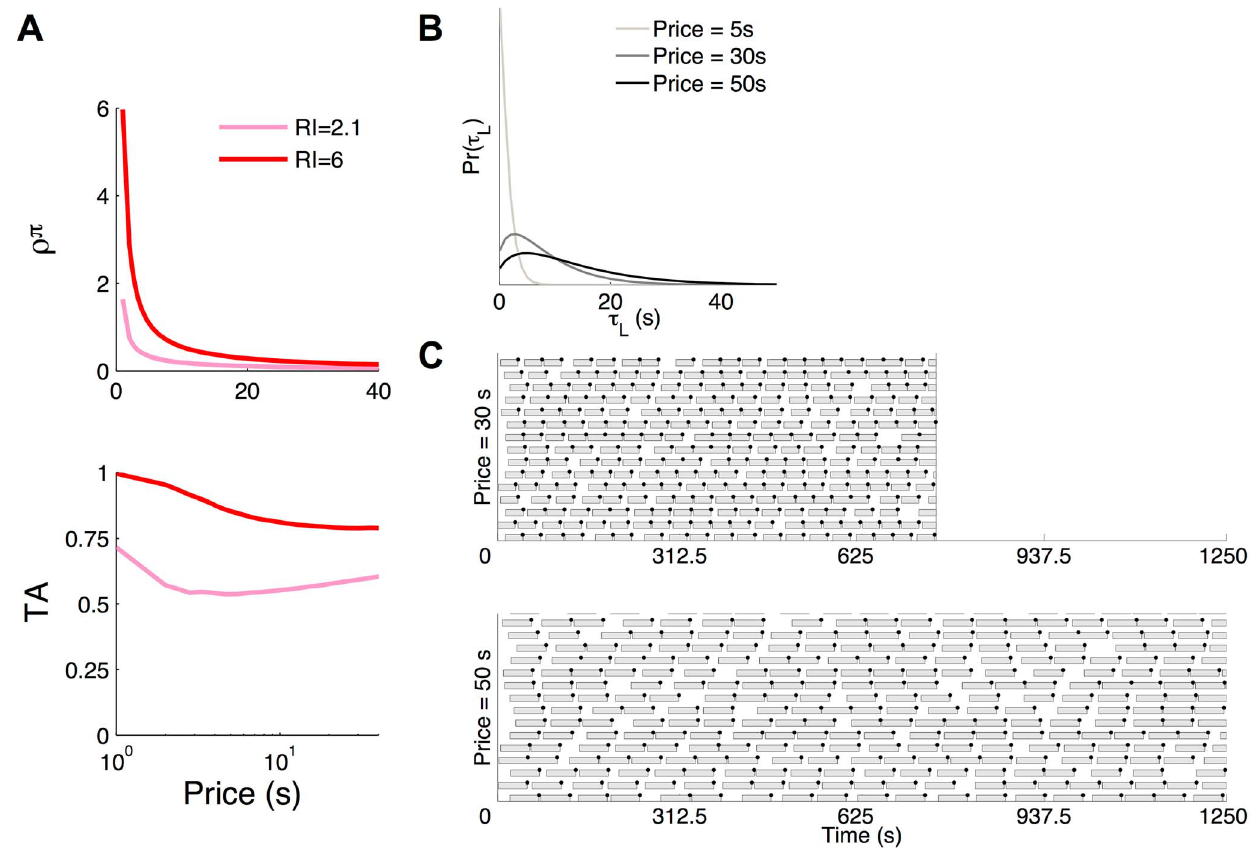
Figure 7. Time allocation may not decrease with price for a non-linear microscopic utility of leisure. A) Upper panel: Reward rate ( r p ) and lower panel: time allocation ( TA ) for a concave microscopic utility of leisure as a function of price. A small and a high reward intensity are shown. Reward rate decreases hyperbolically with price, eventually asymptoting. B) Leisure duration distribution as a function of price for a fixed high reward intensity ( RI ~ 6 ). At very long prices, as the price is increased further (eg. from 30 s to 50 s), the mode of the leisure duration distribution does not change by much although the mean does. C) Ethograms for two long prices. As price is increased, the work bouts (proportional to the price) do increase. Leisure bouts, drawn from the mode, do not change by much. Consequently, TA no longer decreases but may even increase with price (A, lower panel). This is despite the trial duration being normalised to a multiple (here 25) of the price. It is the lack of significant change in the majority of leisure durations that is critical. We normalised by the trial duration of 25 | price, instead of simply normalizing by the price, to emphasise that TA is a macroscopic quantitity and to be consistent with the procedure in the example data Figure S1. to obtain a single reward (black dot) of subjective reward intensity RI . The trial duration is 25 | price . The reward intensity and price are held fixed within a trial. B) Macroscopic time allocation ( TA ) functions of a typical subject as a function of reward intensity and price. Red curves: effect of reward intensity, for a fixed short price; blue curves: effect of price, for a fixed high reward intensity; green curves: joint effect of reward intensity and price. C) Microscopic ethogram showing the detailed temporal topography of working and engaging in leisure for the subject in part of a trial before the reward and price are certainly known is coloured pink and not considered further. Data initially reported